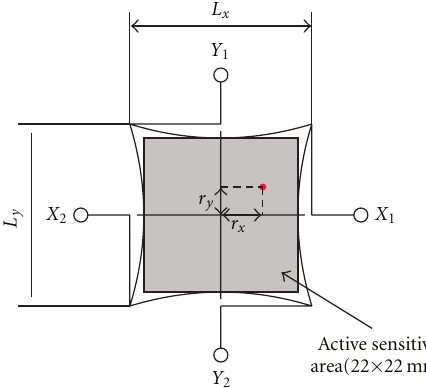
Figure 4: Output signals of optical sensor,